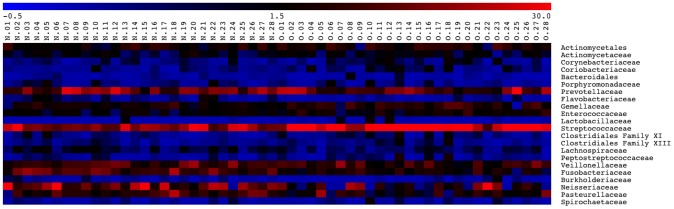
Abundance of bacterial families in salivary samples of N and O subjects.Microbial community structure and relative abundance of principal OTUs in saliva of normal-weight (N) and obese (O) subjects. Legend and scale shown in the upper part of the figure represent colors in the heat map associated with the relative percentage of each OTU within the samples.